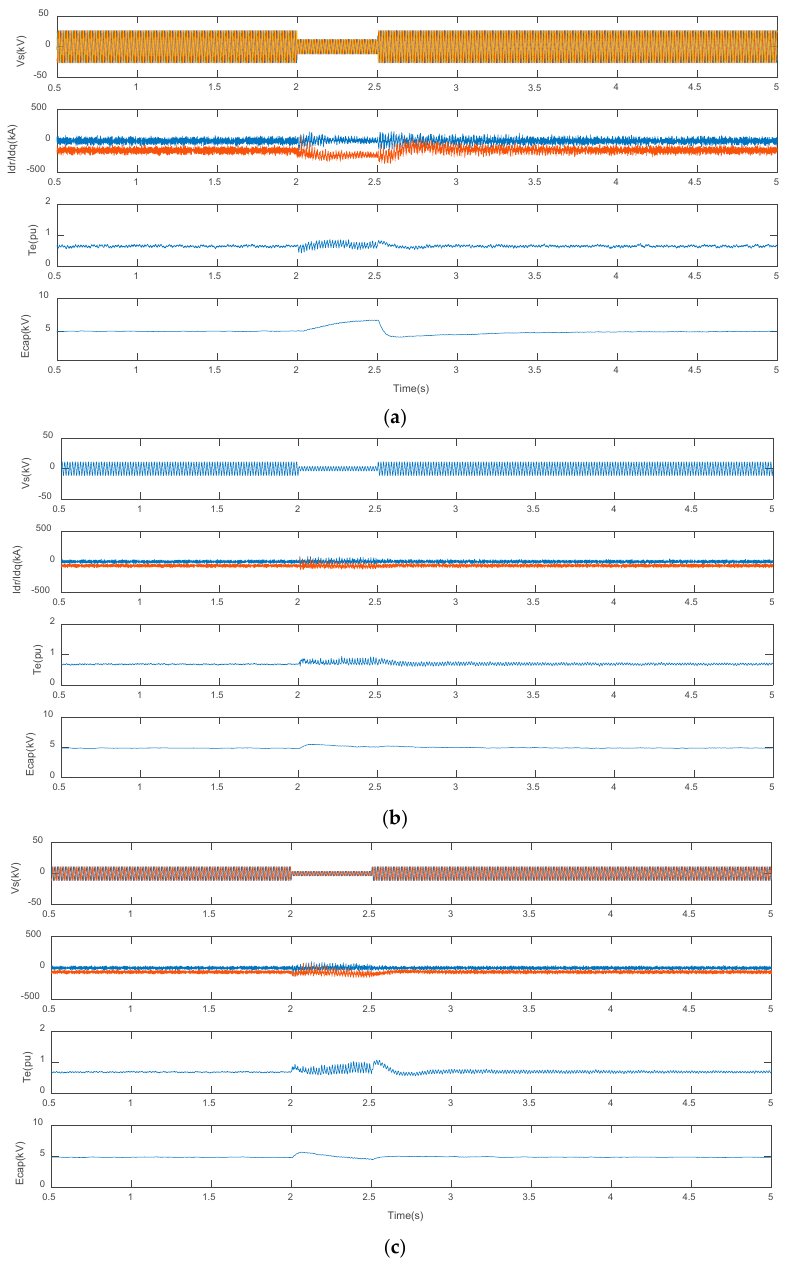
Figure 12. ( a ) Symmetrical voltage dips of 70% rated value; ( b ) Single-phase unsymmetrical voltage dips of 70% rated value; and ( c ) Two-phase unsymmetrical voltage dips of 70% rated value.